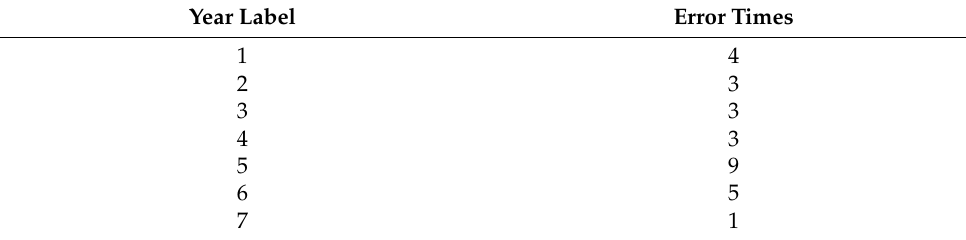
Figure 3. The obfuscation matrix of 10 verification tests. The horizontal and vertical coordinates, respectively, represent the predicted and real years of ginseng. The values on the diagonal refer to the percentage of correct label predictions; other values that are not on the diagonal include the percentage of labels that are incorrectly predicted for the corresponding year label. Table 1. Each year’s label corresponds to the times of prediction errors.